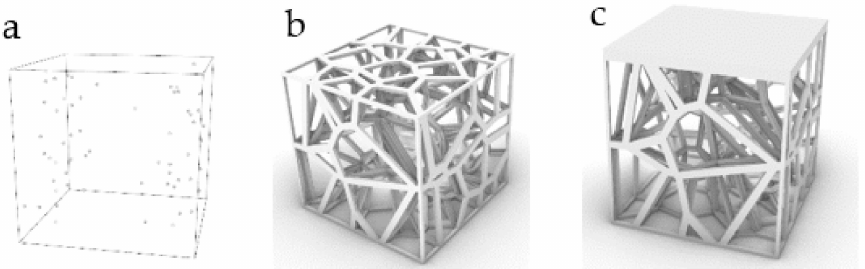
Figure 9. Structure 3: ( a ) Gradient core points distribution; ( b ) Gradient irregular porous structure; ( c ) Gradient irregular porous structure with a thin